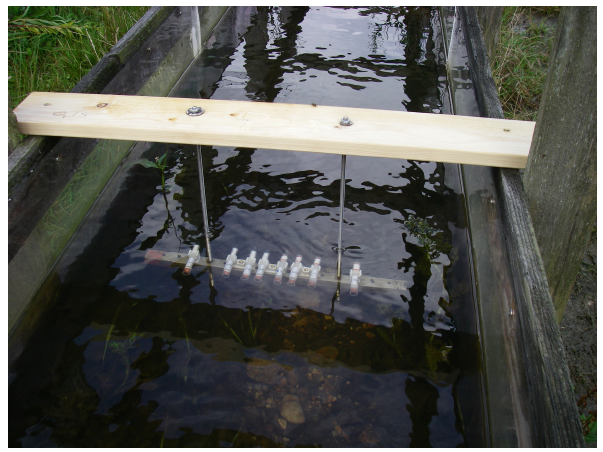
Figure 1. Picture of SorbiCell passive samplers installed in a study